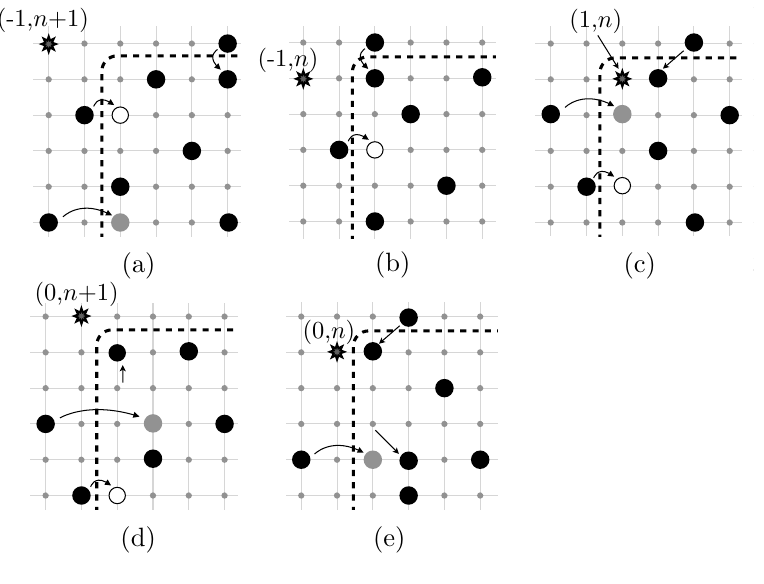
Figure 13: Upper left corner, with the core drawn on the